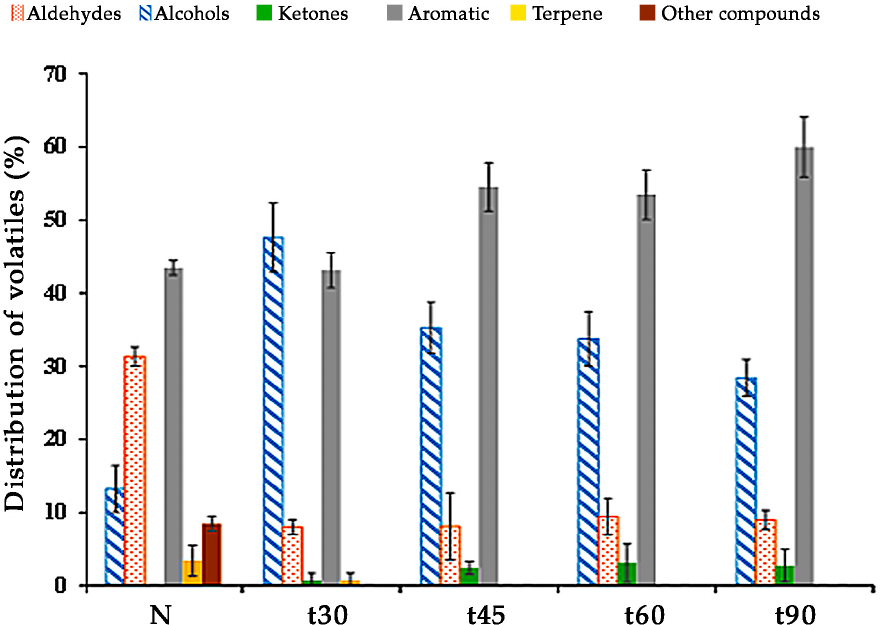
Figure 1. Chemical distribution of volatile compounds of oils from almonds subjected to different thermal treatments before oil extraction.